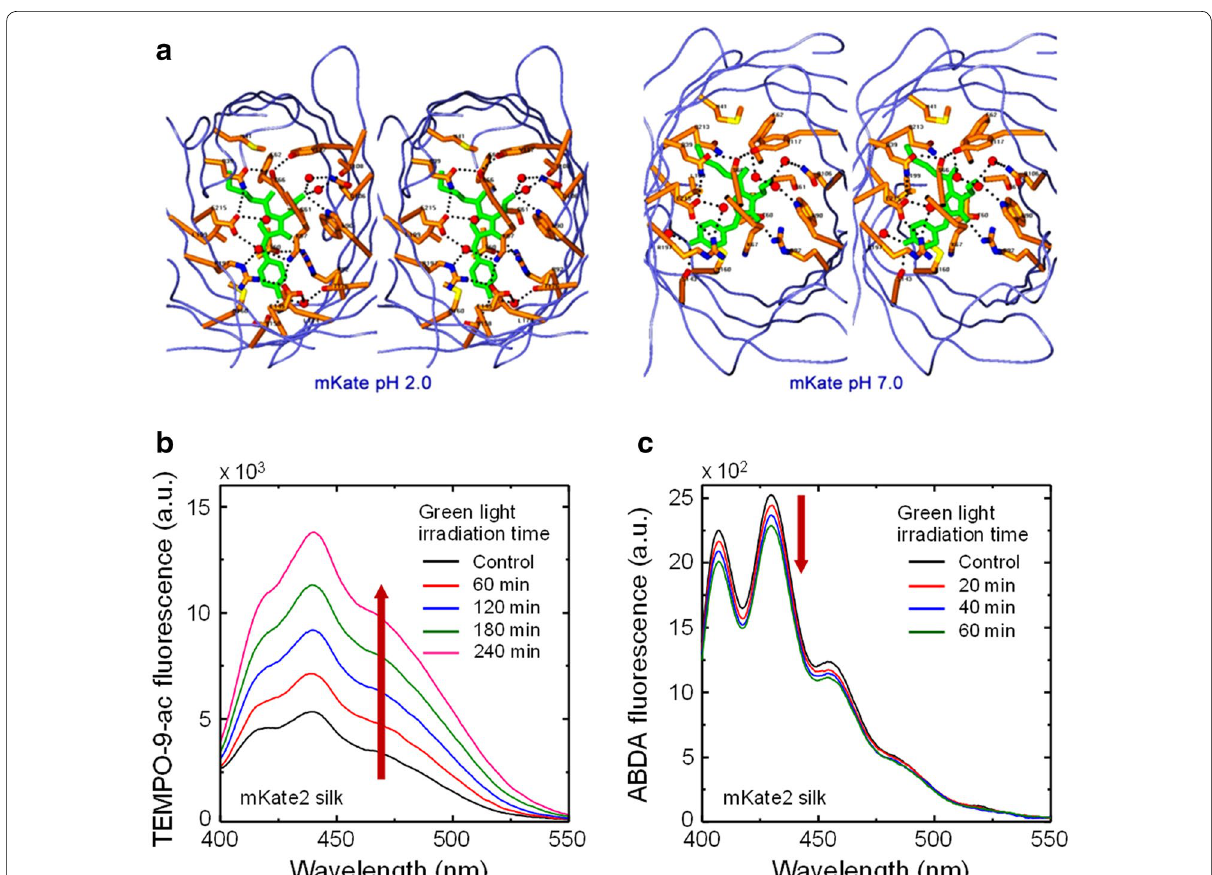
Fig. 9 a 3D structure of the H‑bond network in the vicinity of the trans chromophore (shown in green) for the mKate_pH2.0 structure (left) and the cis chromophore in the mKate_pH7.0 structure (right). Mediating waters are shown by red spheres (Reproduced from [102] with the permission of American Society for Biochemistry and Molecular Biology). b , c Detection of ROS generated by mKate2 embedded in silk (i.e. RFP fluorescent silk produced from silkworm transgenesis) using turn‑on/off fluorescent probes upon green light irradiation at λ ex 532 nm [71]. Fluorescent emission = signals of the probes were monitored from solutions containing mKate2 fluorescent silk. b O 2• ‒ mediated by Type I photosensitization reaction, captured by turn‑on fluorescent signals of TEMPO‑9‑ac (λ ex 365 nm). c 1 O 2 mediated by Type II photosensitization reaction, detected by reduction = in the original ABDA fluorescent intensity